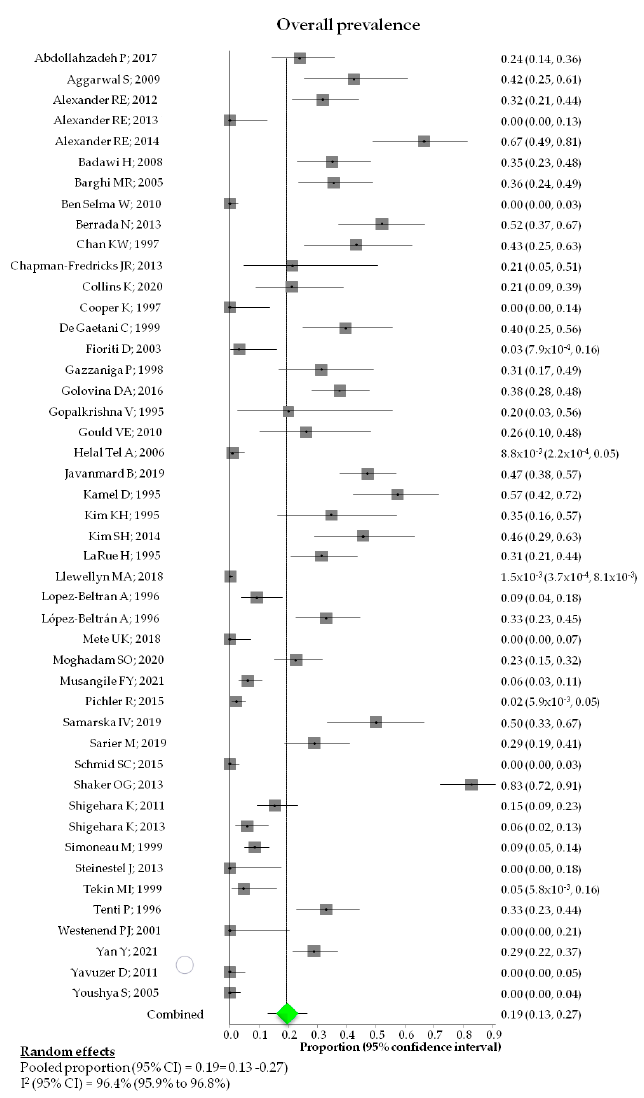
Figure 2. Forest plot of HPV pooled prevalence in bladder cancer. Adapted from [14–59].